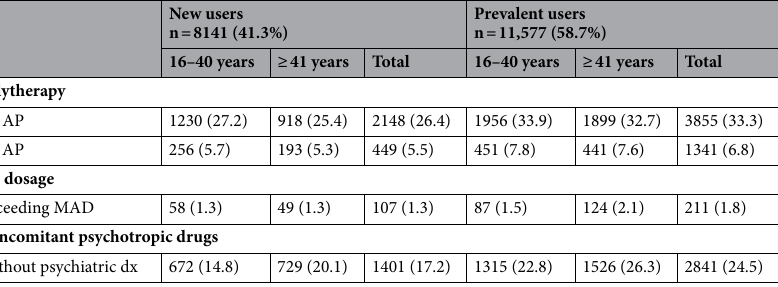
Table 2. Inappropriateness of schizophrenia treatment. AP antipsychotic, MAD maximum allowable dose, dx